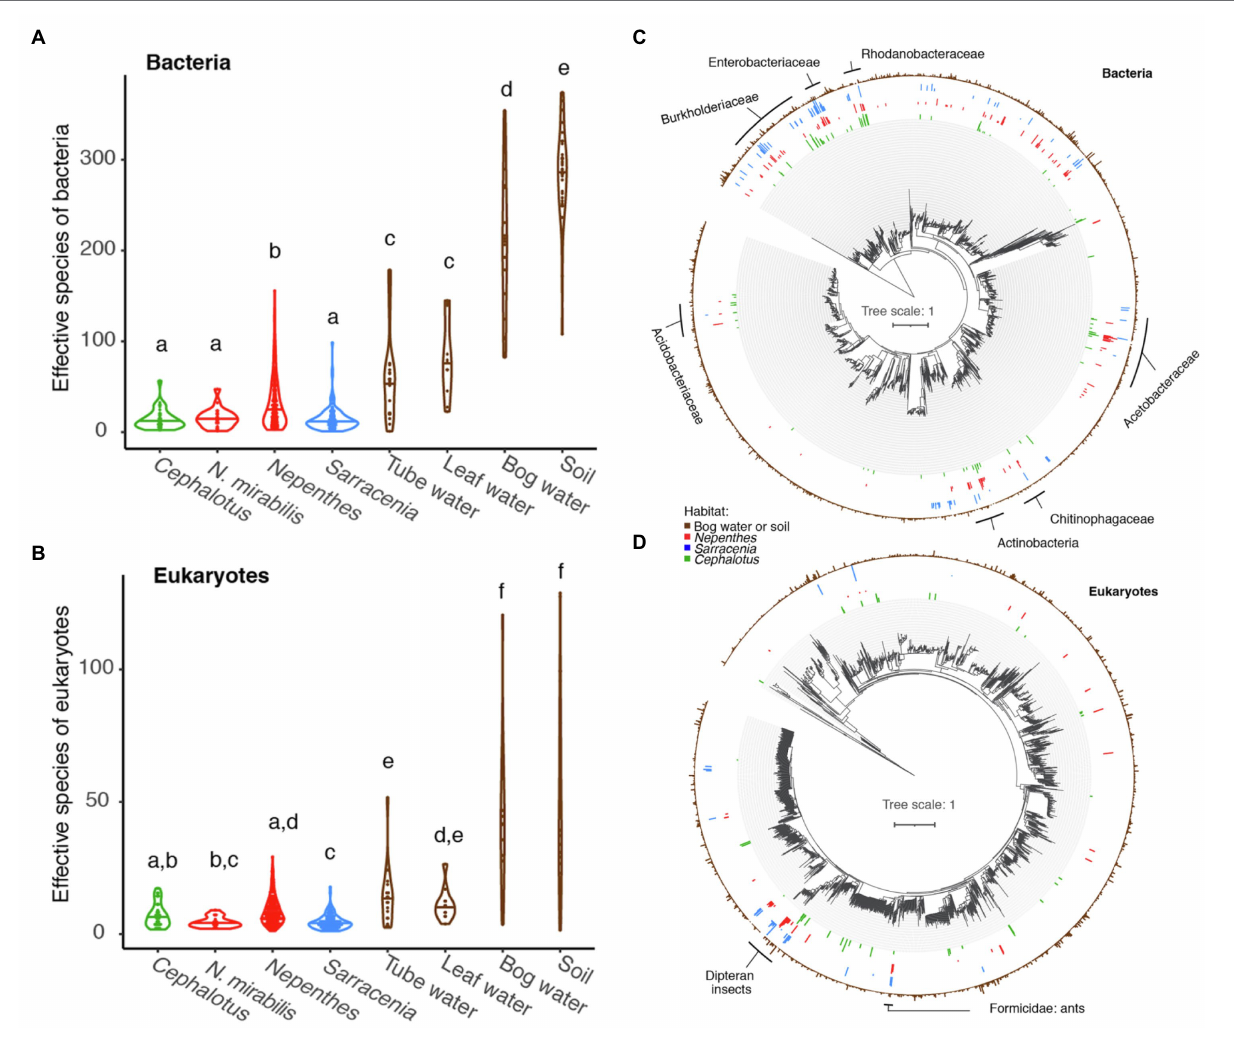
FIGURE 3 | Global comparison of pitcher plant-associated communities. (A,B) Richness measured as effective number of species for Cephalotus follicularis bacteria (A) and eukaryotes (B) in comparison with Australian Nepenthes mirabilis , other Nepenthes , Sarracenia , and environmental communities. Different letters above the violin plots represent significant differences as measured by a pairwise Wilcoxon test, with Benjamini and Hochberg adjustment for multiple comparisons. (C,D) Phylogenetic trees of bacteria (C) and eukaryotes (D) , comparing organisms from environmental samples (brown, outer ring) with those found in at least 10% of our Cephalotus follicularis (green, innermost ring), Nepenthes (red, second innermost ring) and Sarracenia (blue, second outermost ring) samples. Names of selected shared clades are